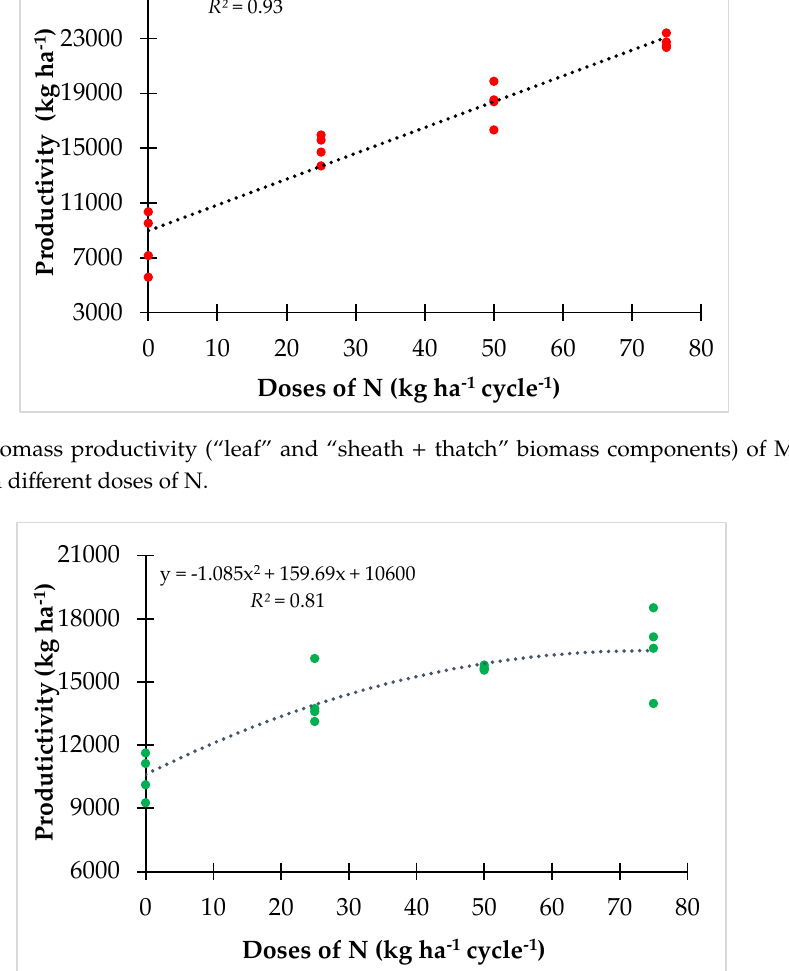
Figure 4. Biomass productivity (“leaf” and “sheath + thatch” biomass components) of Marandu cultivar with different doses of N.